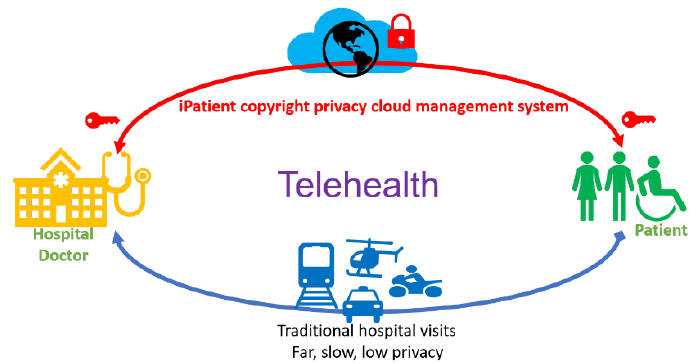
Figure 1. iPatient privacy copyright cloud management system scenario map.